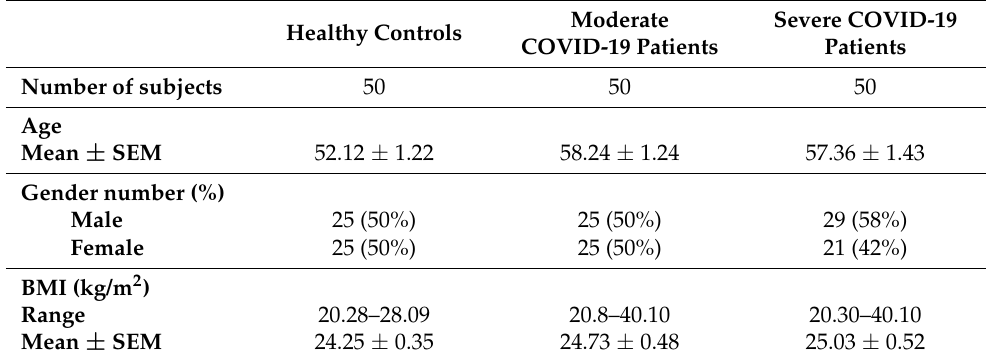
Table 1. Demographic data of studied